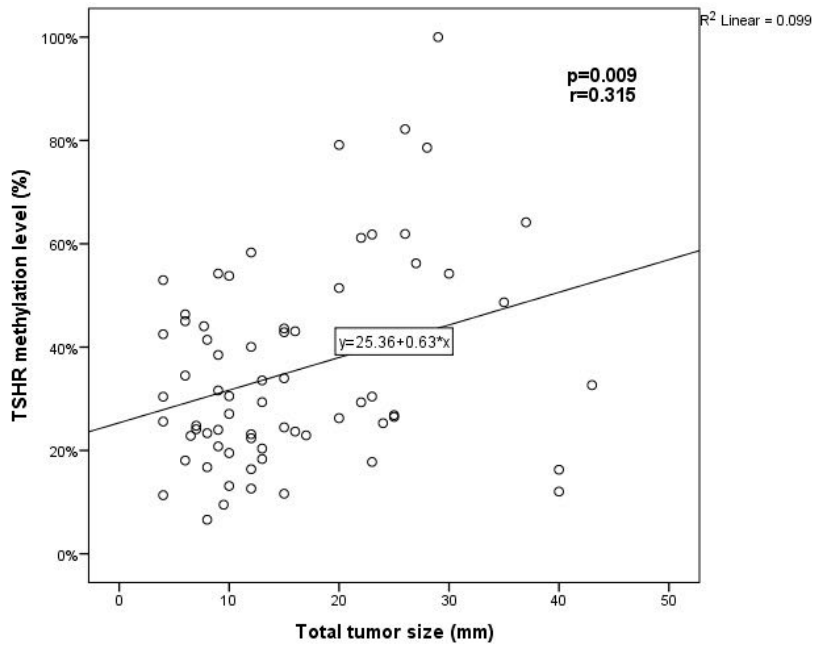
Figure 4. The correlation between TSHR methylation level and the total tumor size. The Pearson correlation coefficient was used to measure the strength of a linear association between two variables.